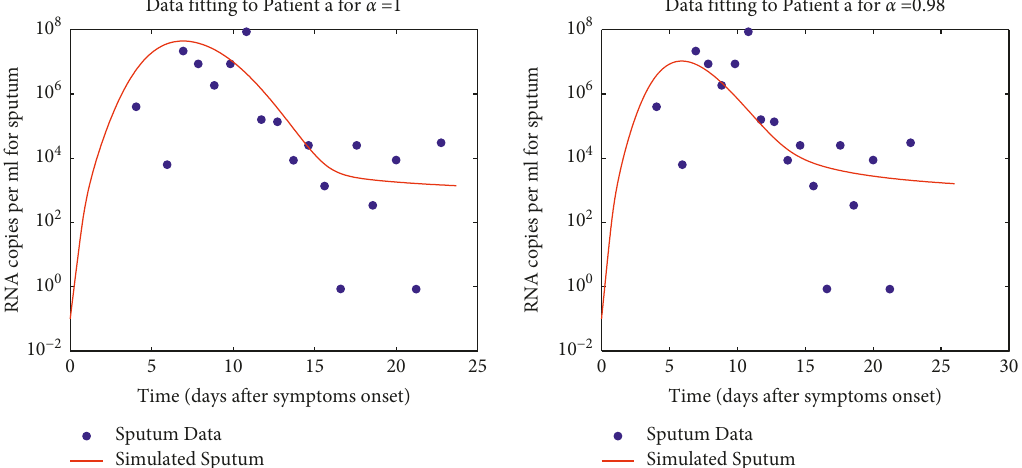
Figure 4: Data fitting for patient e .